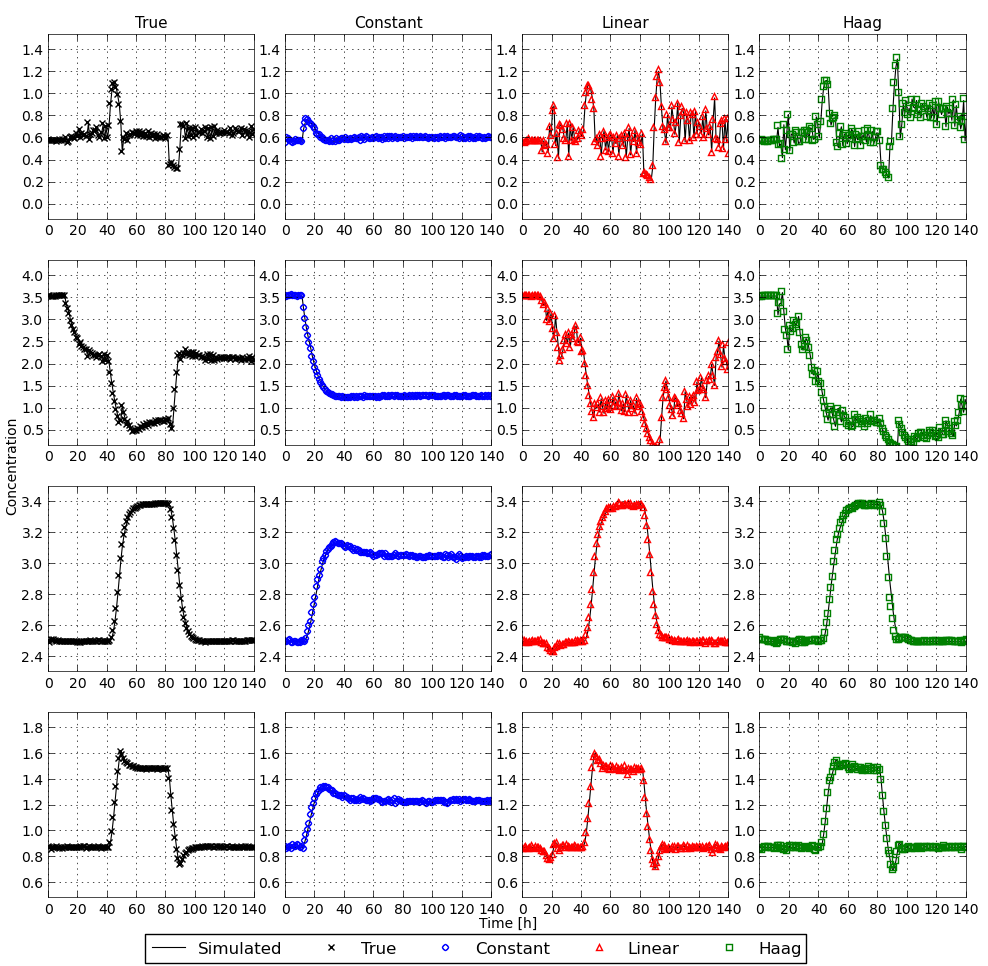
Figure 6. Simulated and estimated concentration profiles with the different flux